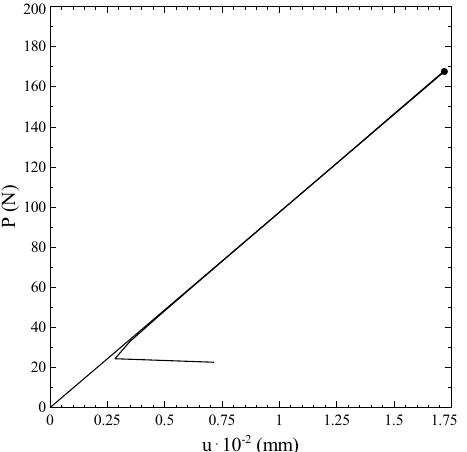
Figure 10. Post-critical deformed shapes along the equilibrium paths 1 to 4: ( a ) path 1, ( b ) path 2, ( c ) path 3, ( d ) path 4.